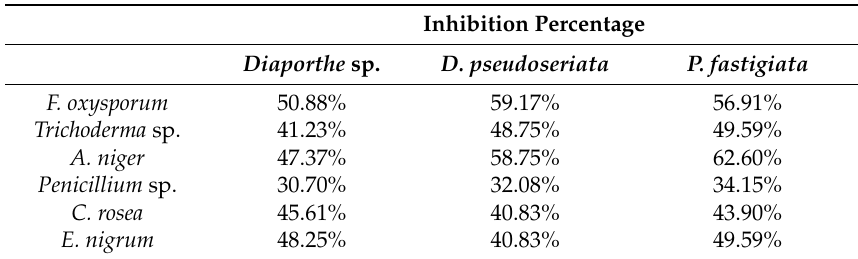
Table 5. Inhibition percentages of Diaporthe sp., Diplodia pseudoseriata , and Phialophora fastigiata by the endophytic fungus Fusarium oxysporum , Trichoderma sp., Aspergillus niger , Penicillium sp., Clonostachys rosea , and Epicocum nigrum , calculated 9 days after inoculation. Inhibition Percentage Diaporthe